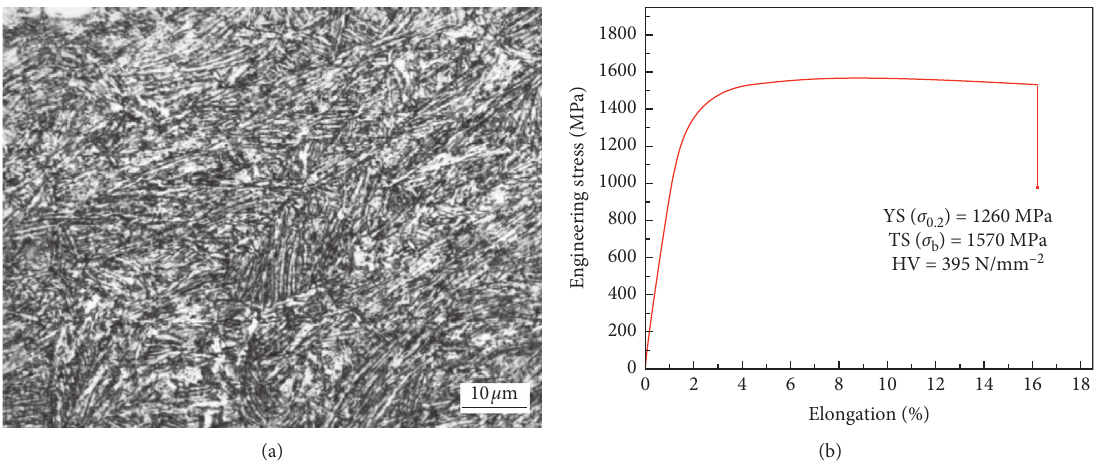
Figure 2: Original microstructure (a) and mechanical properties (b) of examined